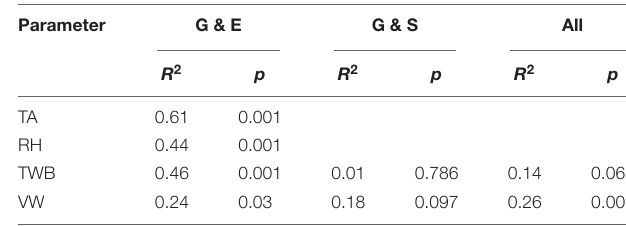
TABLE 4 | Results of linear regression analysis with water loss (Y) as dependent variable and air temperature (TA), relative humidity (RH), wet-bulb temperature (TWB), and wind speed (VW) as explanatory